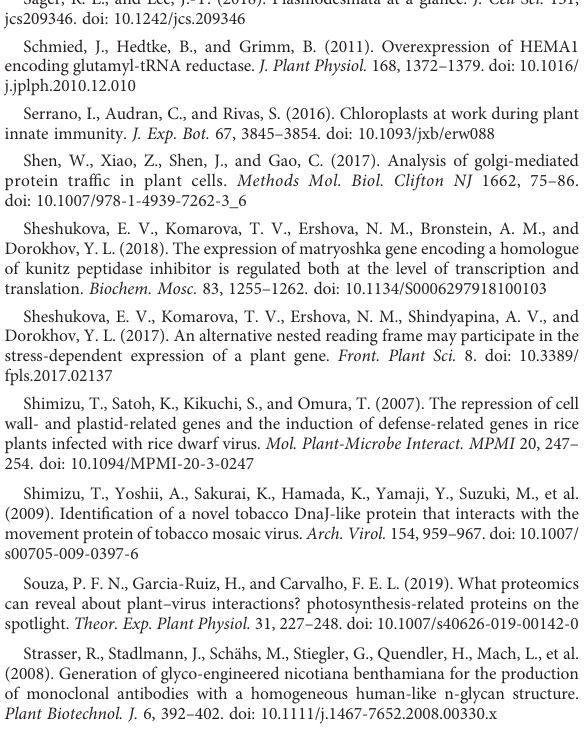
Tabler, M., and Tsagris, M. (2004). Viroids: petite RNA pathogens with distinguished talents. Trends Plant Sci. 9, 339 – 348. doi: